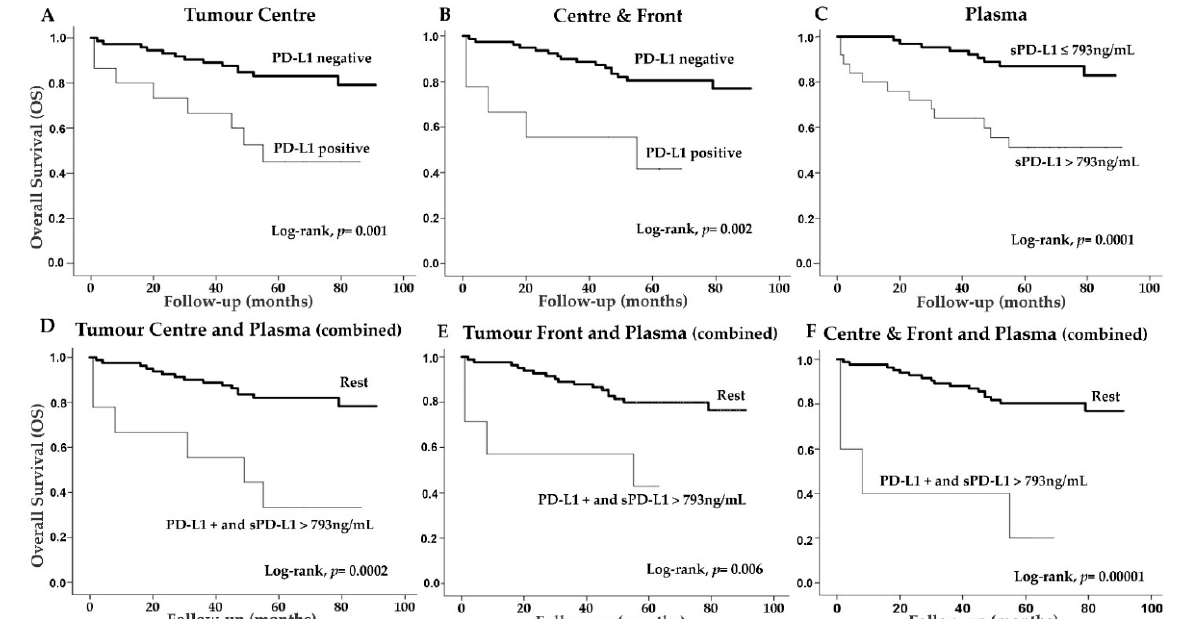
Figure 4. Immunohistochemical PD-L1 expression and plasma sFAP levels according to CCRCC patients’ 5-year overall survival (OS). Kaplan-Meier curves and univariate Log-rank test showed that PD-L1 expression at tumor center ( A ) and concomitant expression at center and border ( B ) is associated to worse OS. ( C ) CCRCC patients with sPD-L1 above 793 ng/mL had worse OS. The expression of PD-L1 at tumor center ( D ), front ( E ) or at both areas ( F ) together with plasma sPD-L1 levels above 793 ng/mL are associated with worse OS.